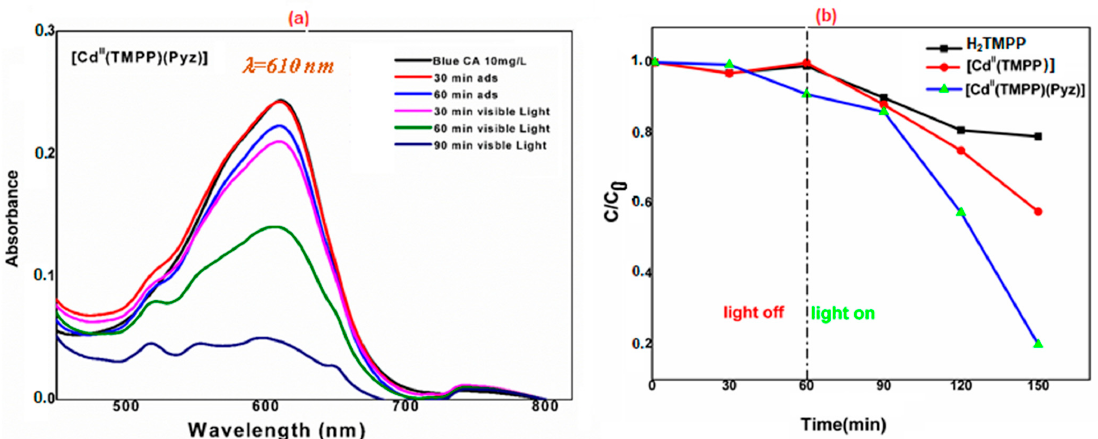
Figure 12. ( a ) Degradation of Levafix Blue CA reactive dye for different samples in aqueous solution (C is the Blue CA concentration at time t, and C 0 is the concentration of the dye at t = 0); ( b ) Variation of Blue CA concentration as a function of irradiation time using 20 mg of [Cd(TMPP)(Pyz)] ( 1 ). The reusability of [Cd(TMPP)(Pyz)] ( 1 ) for photocatalytic degradation of Levafix Blue